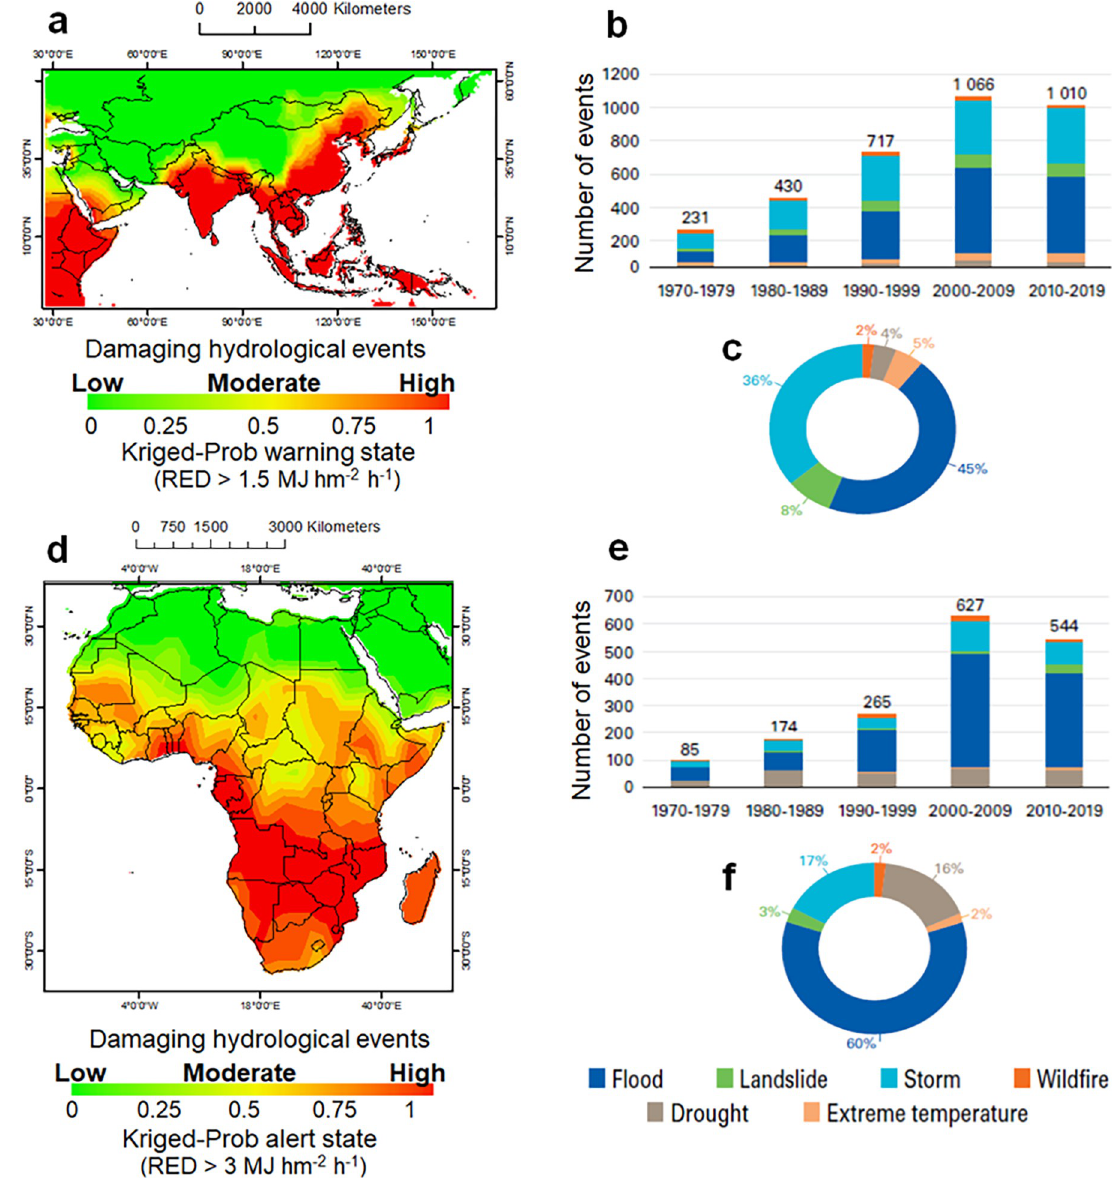
Fig 8. Comparison of kriged probability maps with damaging hydrological events (Asia) and flood events (Africa) over the last four- five decades. a) Rainfall erosivity density (RED) > 1.5 MJ hm -2 h -1 with b) with trend of disasters and c) related percentage; d) Rainfall erosivity density (RED) > 3.0 MJ hm -2 h -1 with e) trend of disasters and f) related percentage. The graphs a) and d) refer to the period 2002–2011, graphs b), c), e) and f) to